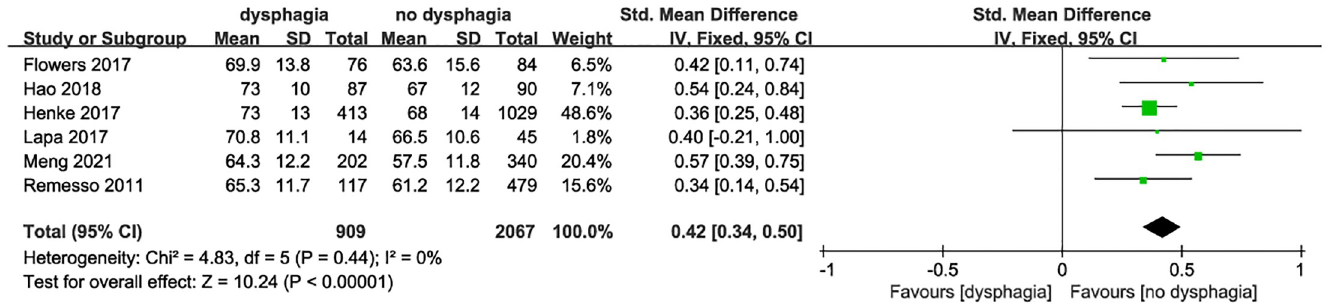
Fig 2. Forest plot for the relationship between age and dysphagia after stroke.